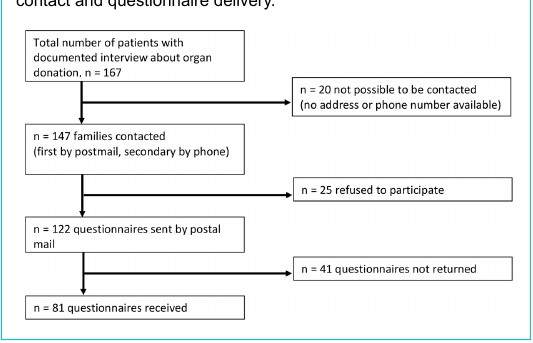
Figure 1: Study flow chart illustrating the sequence of next of kin contact and questionnaire delivery.